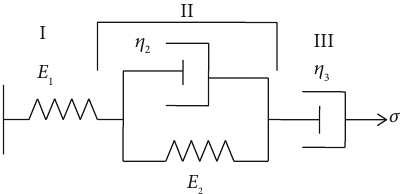
Figure 1: Mechanical model of a material undergoing elastic (I), viscoelastic (II), and viscous (III)